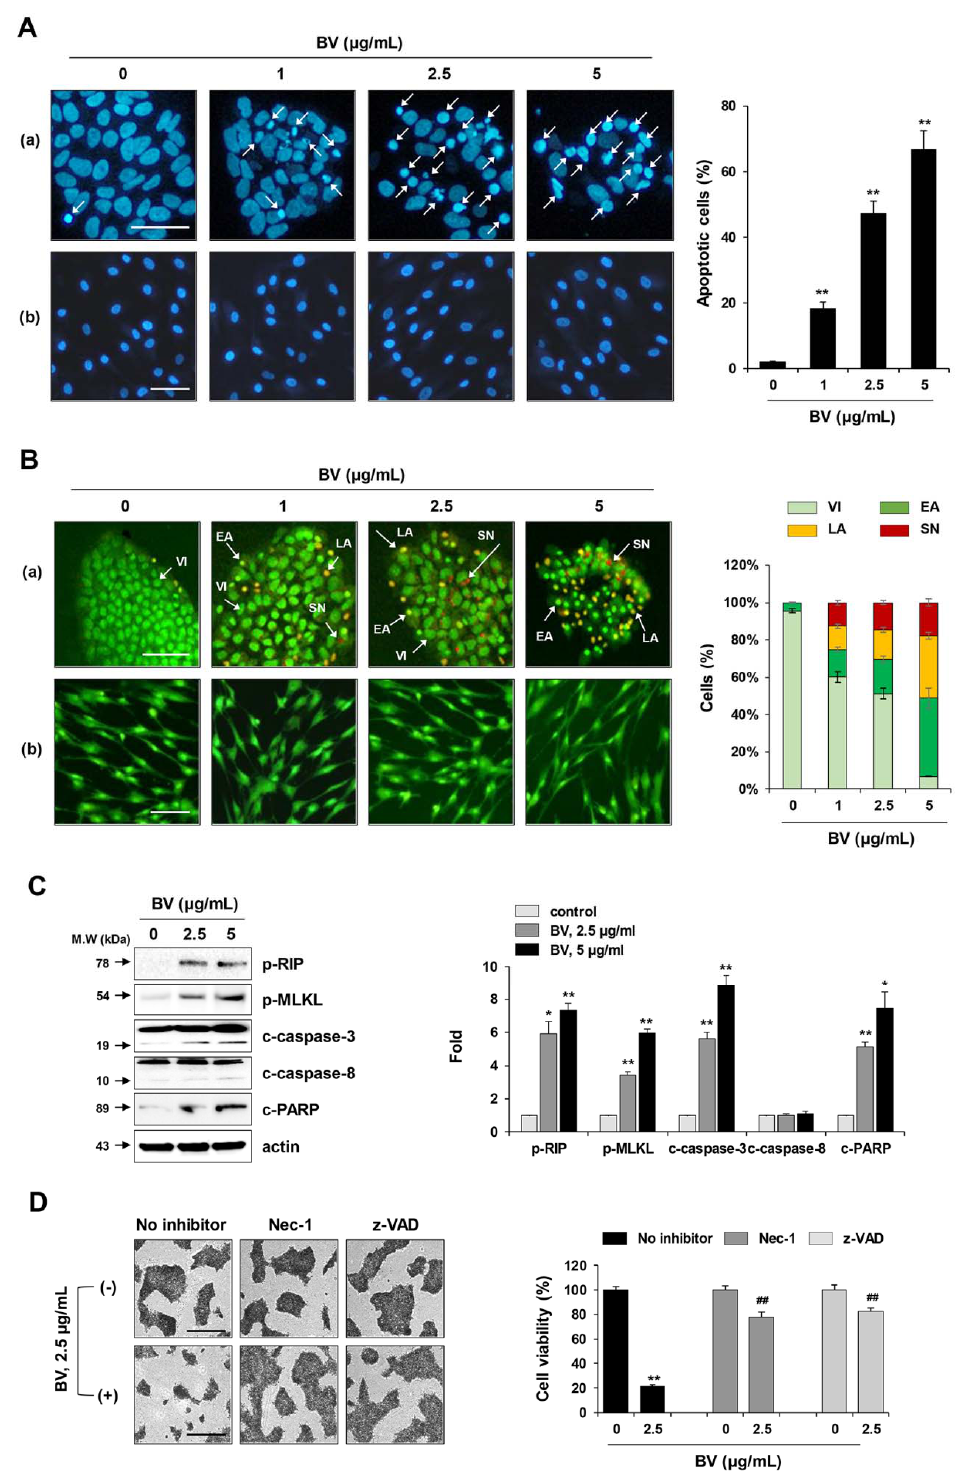
Figure 3. Induction of both apoptotic and necrotic cell death by BV treatment in iPSCs. ( A ) iPSCs (a) and iPSCs ‐ Diff (b) were treated with 1, 2.5, and 5 μ g/mL BV for 1 h, stained with DAPI, and then chromatin condensation was observed under a fluorescence microscope. Apoptotic cells (white